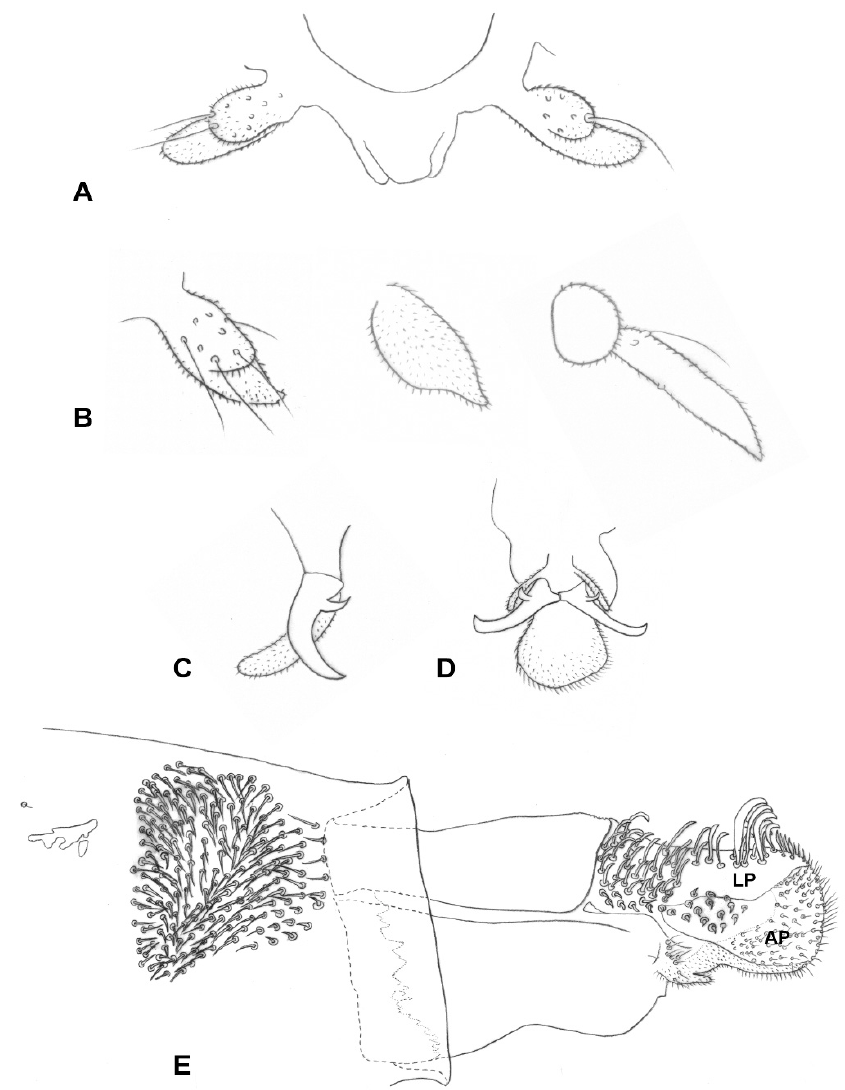
Figure 4. Ruschiola succulenta . ( A ) Palpi. ( B ) Variation in palpus morphology. ( C ) Acropod, lateral. ( D ) Acropod, ventral. ( E ) Ovipositor, lateral. LP: lateral plate; AP: apical lamella.